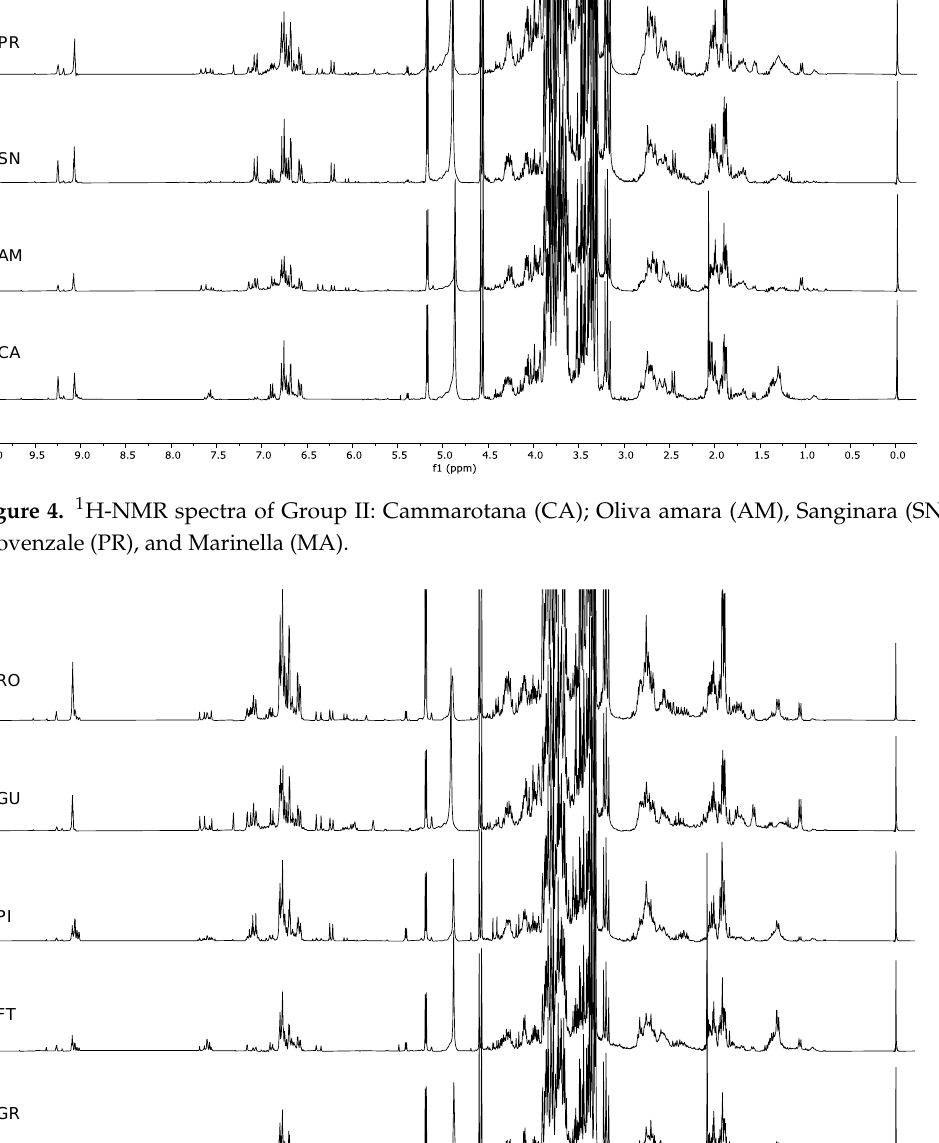
Figure 5. 1 H-NMR spectra of Group III: Grossale (GR), Femminella (FT), Pizzulella (PI), Guglia (GU), and Racioppella (RO).